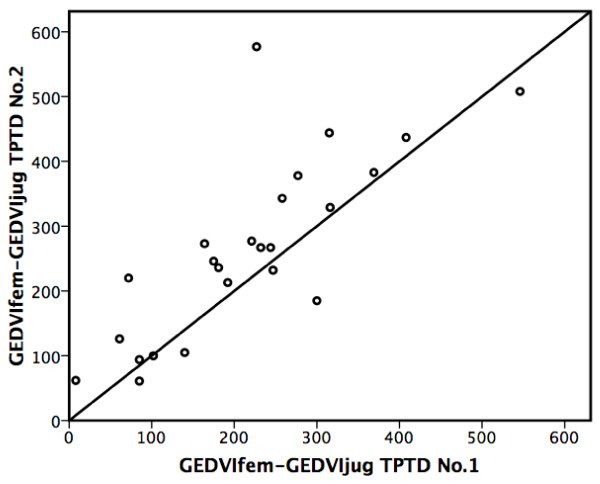
Intra-individual correlation of the two pairs of transpulmonary thermodilution measurements. Scatter plot demonstrating significant intra-individual correlation of the two pairs of transpulmonary thermodilution measurements (No. 1 and No. 2) in each patient (r = 0.79; P < 0.001). GEDVIjug, jugular global end-diastolic volume index (mL/m2); GEDVIfem, femoral global end-diastolic volume index (mL/m2); GEDVIfem - GEDVIjug, difference between GEDVI values after femoral and jugular injection; TPTD, transpulmonary thermodilution.